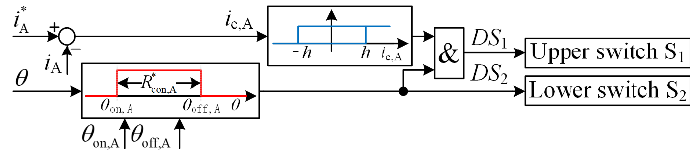
Figure 9. Block diagram of soft current chopping control.